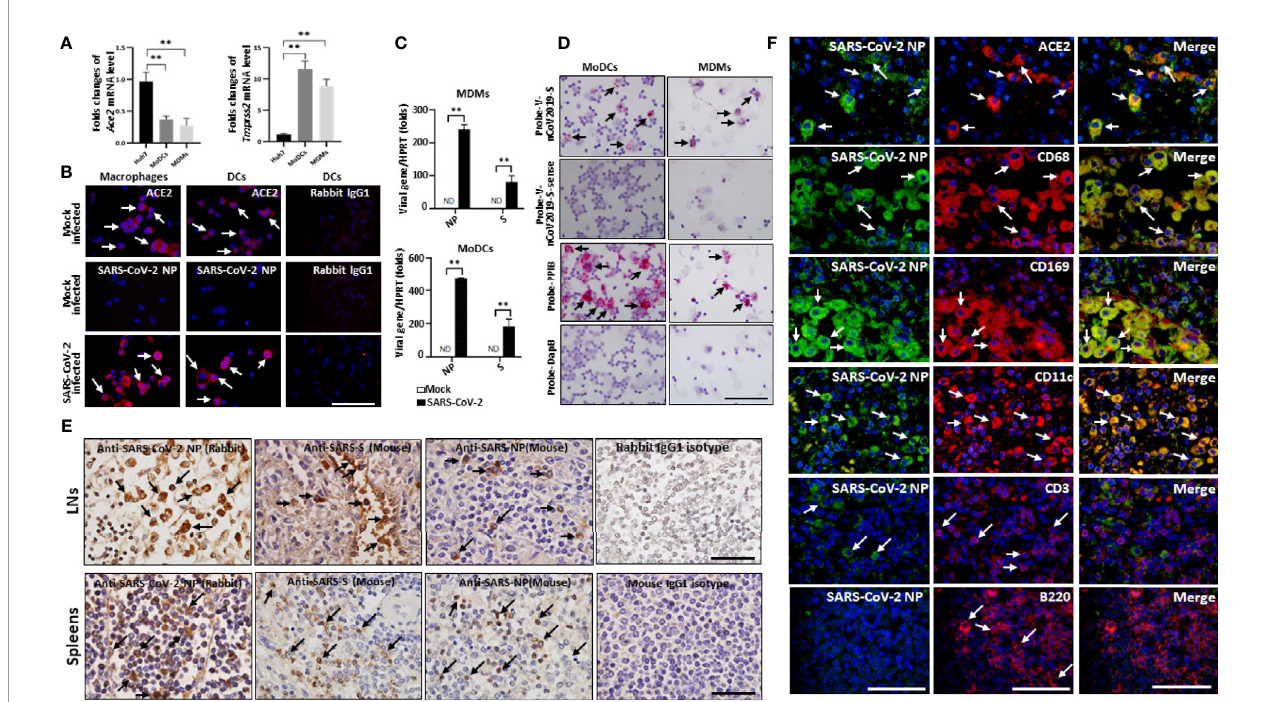
FIGURE 4 | SARS-CoV-2 directly infects human macrophages and DCs. Human MDMs and MoDCs were mock infected or infected with SARS-CoV-2 (MOI =1.0) for 2h, after virus absorption, cells were washed and continuously cultured for additional 24h, (A) The expression of endogenous ACE2, TMPRSS2 were evaluated in MDMs, MoDCs and Huh7 cells, ** p < 0.01. (B) The expression of ACE2 and SARS-CoV-2 NP antigen was detected by immuno fl uorescent staining; (C) qPCR analysis of SARS-CoV-2 viral RNA, ** p < 0.01. (D) the presence of SARS-CoV-2 viral RNA was detected by RNA ISH, the reactivity for PPIB was used as positive control; The spleens and hilar LNs from one representative COVID-19 post-mortem (case #3) were collected, (E) sections were incubated with primary anti-SARS- NP antibodies (clone ID: 019, rabbit IgG; and ab273434, mouse monoclonal 6H3), anti-SARS-S antibodies (ab273433, mouse monoclonal 1A9), or with mouse or rabbit IgG1 control antibodies, and the expression of viral NP and S antigens were analyzed by IHC, scale bar = 50 m M, arrows indicate positive cells; (F) The hilar LNs were incubated with primary anti-SARS-NP antibodies (clone ID: 019, rabbit IgG) and other mouse derived antibodies, SARS-CoV-2 NP antigen in indicated cells was analyzed by immuno fl uorescent double staining. Scale bar = 50 m M, arrows indicated double positive cells and arrow heads showed single positive